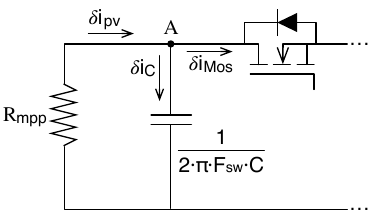
Figure 10. High-frequency model at the panel